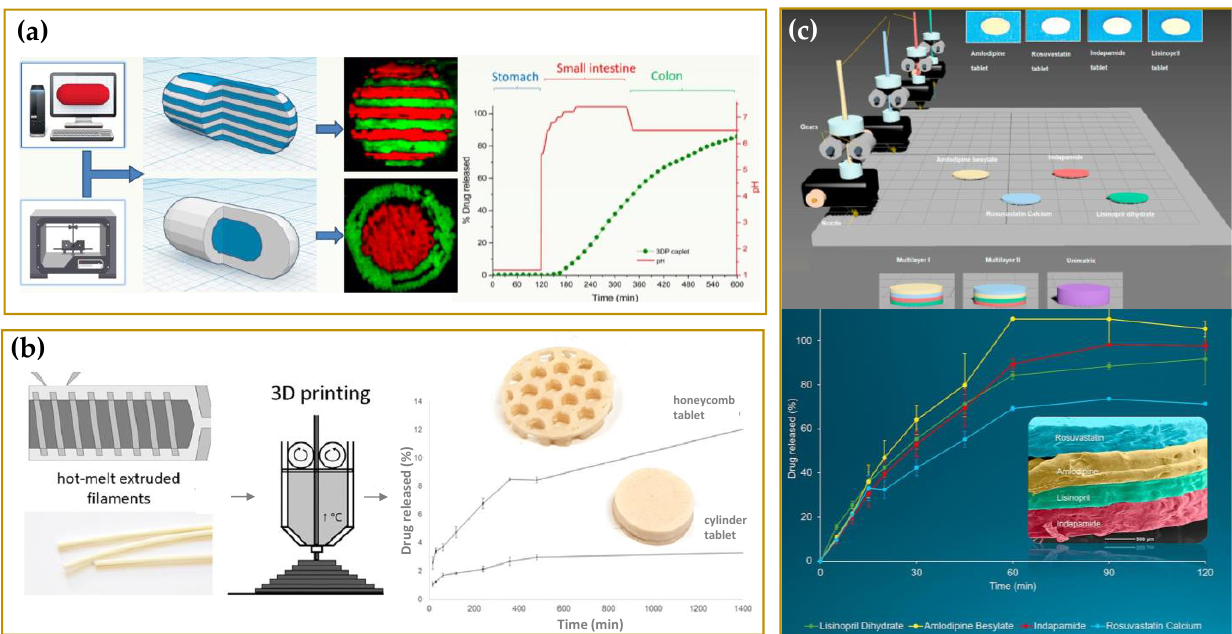
Figure 13. Examples of 3D printed oral dosage forms produced by FFF technique. ( a ) Multilayer device and Duo-caplet. Adapted with permission from reference [155]; copyright (2015) American Chemical Society; ( b ) HME polycaprolactone-based filaments intended for 3D-printing of tablets with a lattice (“honeycomb”) structure. Reprinted with permission from reference [136]; copyright (2020) Elsevier B.V.; ( c ) Cardiovascular ‘Polypill’ loaded with four different drugs. Reprinted with permission from reference [159]; copyright (2018) Elsevier B.V.